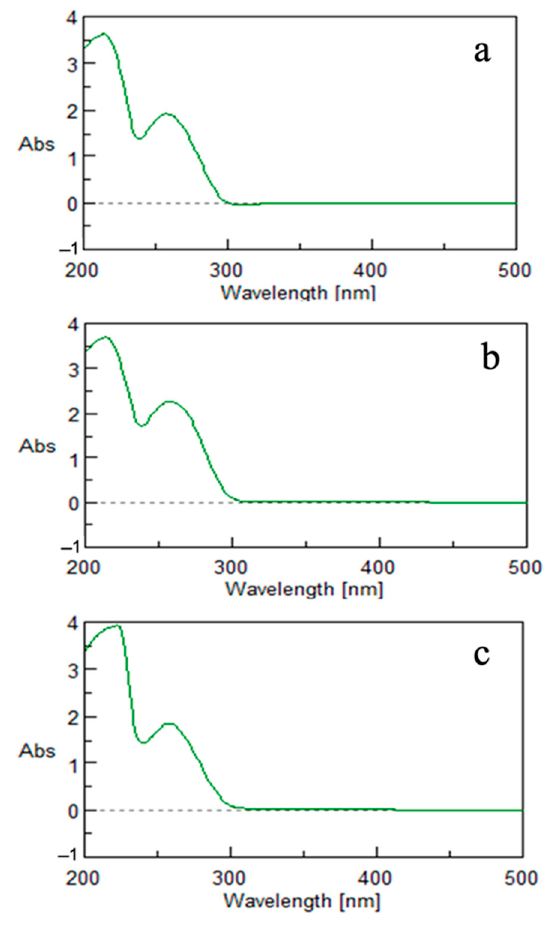
Figure 14. UV–Vis spectra of SeNPs produced in medium A (panel ( a )), medium B (panel ( b )), and waste-based medium C (panel ( c )).